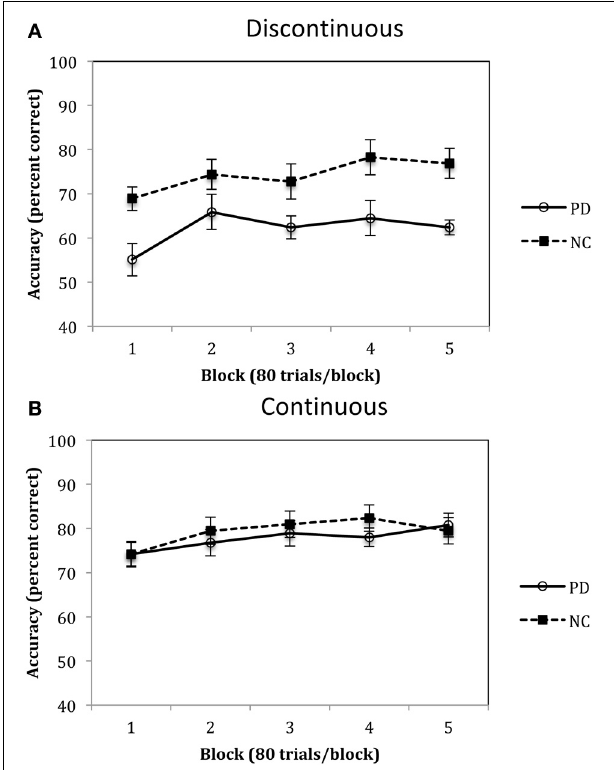
FIGURE 7 | Accuracy (percent correct) for PD patients and NC participants for the (A) Discontinuous and (B) Continuous conditions in Experiment 2. (Error bars are in standard error of the